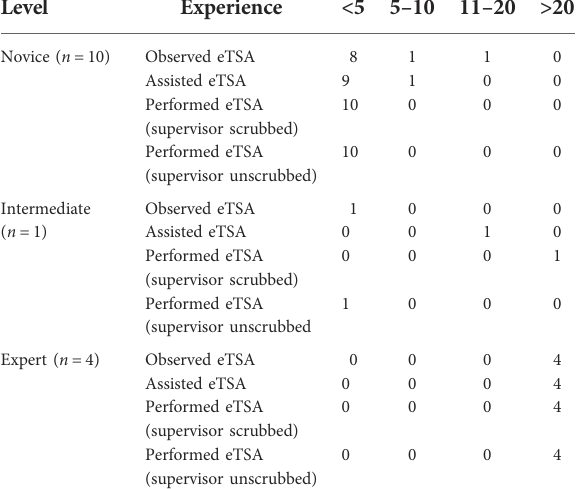
TABLE 2 Participant experience.